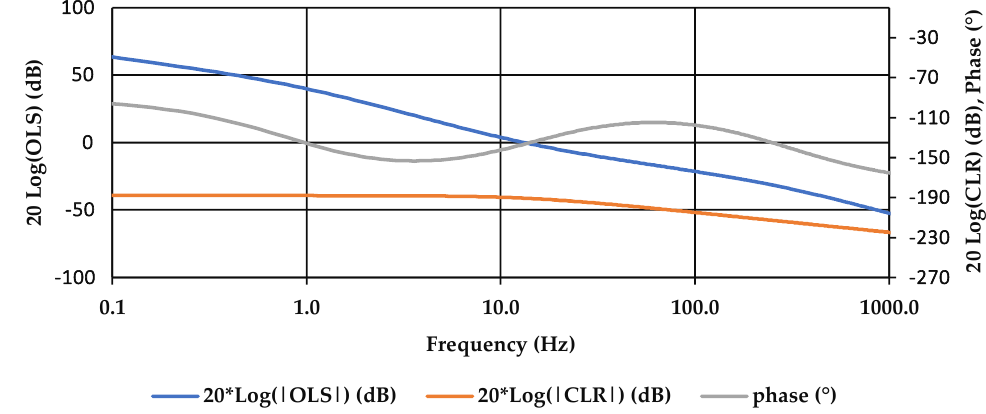
Figure 7. Frequency response for unbound system design solution 2.